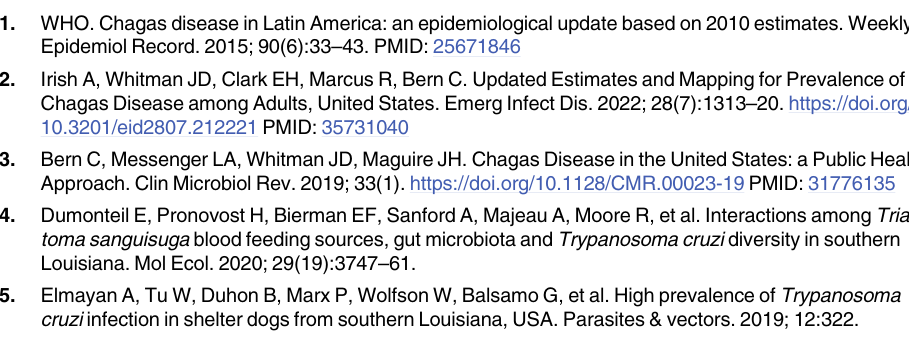
S1 Fig. Rarefaction curves for individual samples. Curves indicate adequate sequencing depth for samples included in the analysis. S2 Fig. Comparison of alfa and beta diversity of second and third stage nymphs. For alpha diversity, there was no significant difference in Shannon (t = 0.45, P = 0.65) and Chao1 indices (t = 1.34, P = 0.21) between second (N2) and third stage nymphs (N3). Beta diversity was also not different between N2 and N3 (PERMANOVA, F = 1.9; P =